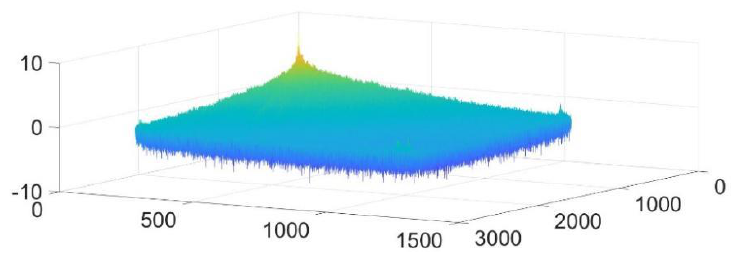
Figure 4. DCT transform spectrum diagram.